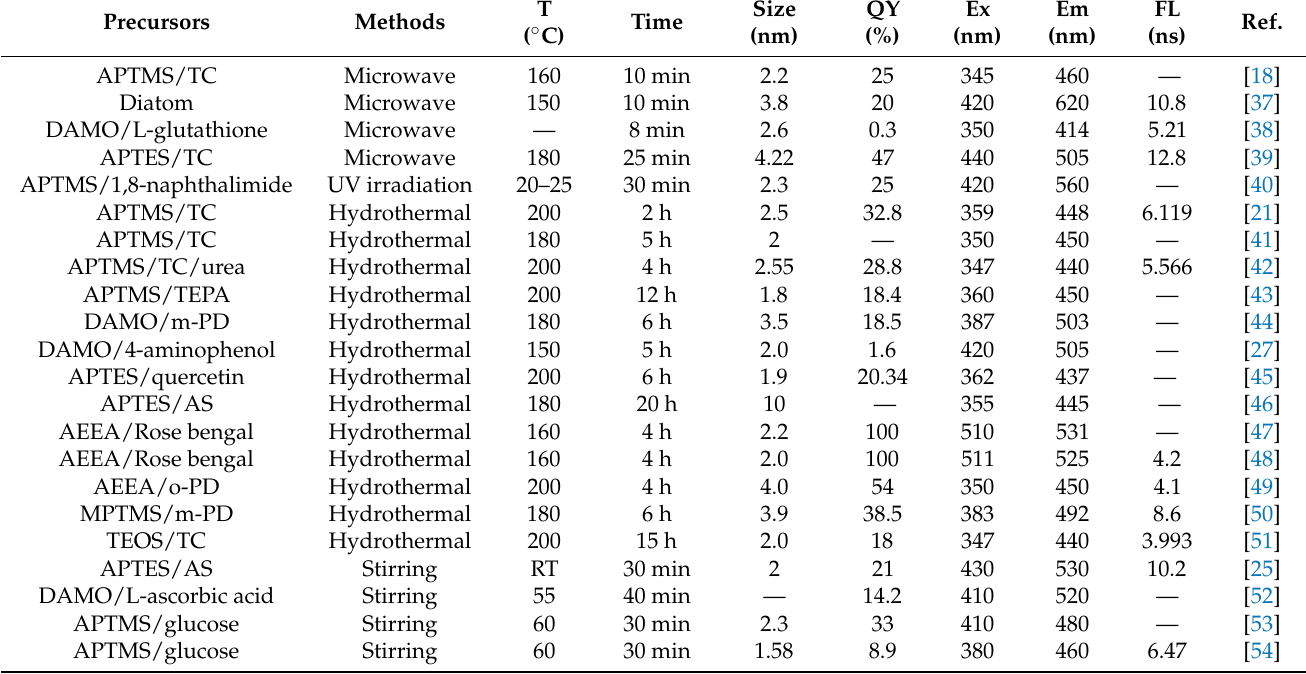
Table 1. Some properties of water-souble SiQDs synthesized by the “bottom-up”